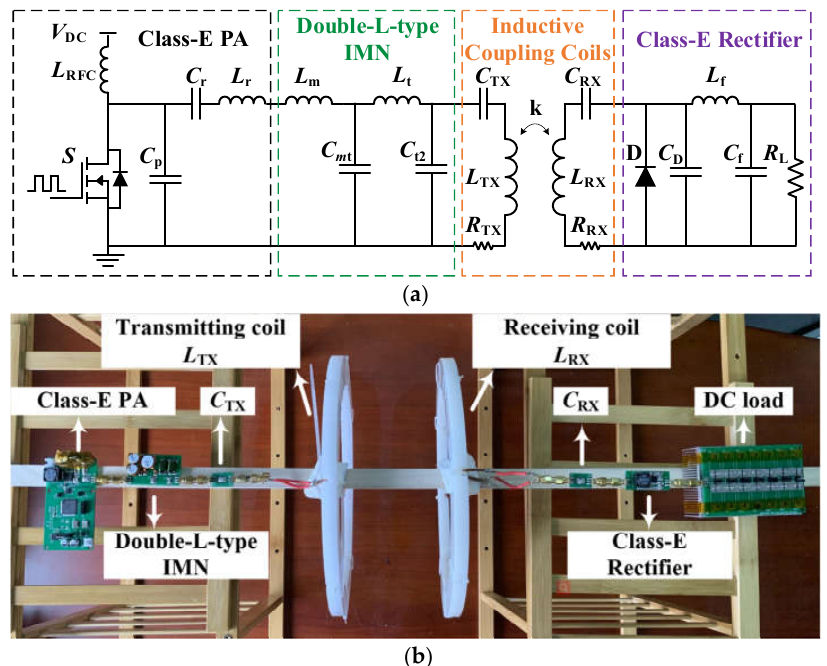
Figure 8. Experimental circuit of proposed Class-E2-based WPT system: ( a ) schematic; ( b ) photograph.